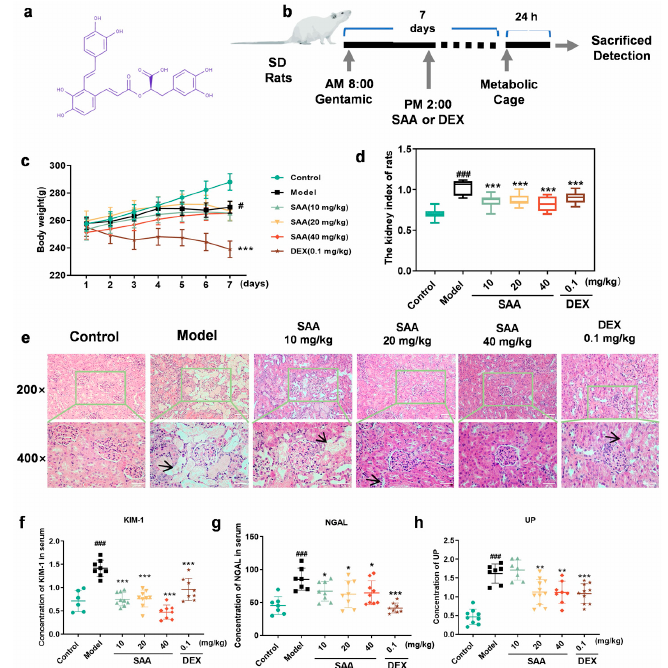
Figure 1. SAA suppressed kidney damage in AKI rats. ( a ) Characterization of SAA. ( b ) Flow chart for preparation of AKI model in SD rats. ( c ) The effect of SAA on the body weight. ( d ) The effect of SAA on the kidney index of rats. (All data are shown as mean ± SEM, n = 10–12. # p < 0.05, ### p < 0.001 compared with Control group; *** p < 0.001 compared with Model group.) ( e ) The effects of SAA on histopathological changes in rats. Kidney histopathological changes were observed by H&E staining ( n = 3, magnification: 200 × , 400 × , scale bar = 100 µ m, 50 µ m), black arrow indicates kidney tubular dilatations. ( f , g ) Effect of SAA on serum ( f ) KIM-1 and ( g ) NGAL in rats with AKI. ( h ) The effect of SAA on the content of UP. (Green circle represents Control. Black square represents Model. Light green triangle represents 10 mg/kg SAA. Yellow inverted triangle represents 20 mg/kg SAA. The red diamond represents 40 mg/kg SAA. Brown asterisk represents DEX. All data are shown as mean ± SEM, n = 6–10. ### p < 0.001 compared with Control group; * p < 0.05, ** p < 0.01, *** p < 0.001 compared with Model